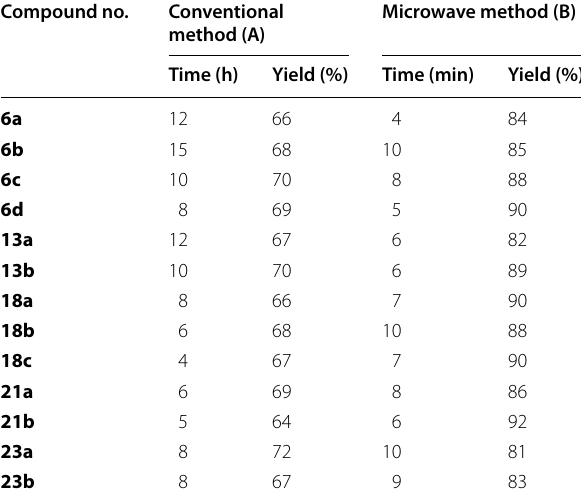
Table 1 Comparative data of conventional (A) and MW (B) methods for the synthesis of compounds 6a–d, 13a, b, 18a–c, 21a, b and 23a, b Compound